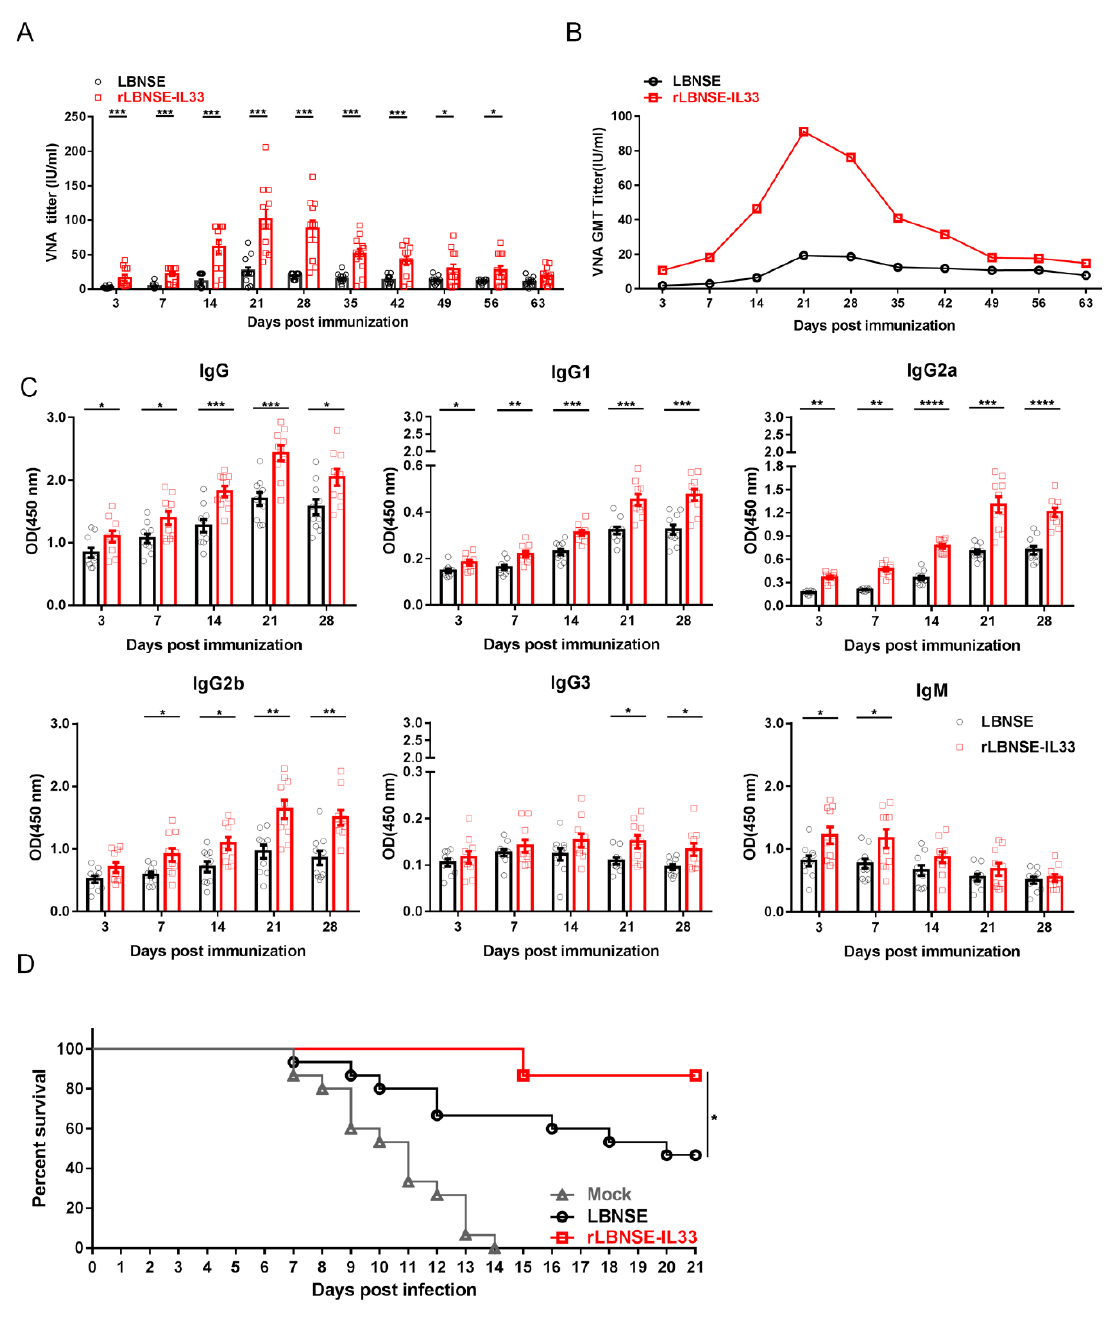
Figure 9. Overexpression of IL-33 in rRABV improved antibody responses and protection against rabies. Six-week-old female ICR mice were immunized with LBNSE (10 6 FFU), rLBNSE-IL33 (10 6 FFU), or DMEM (as mock) via i.m. route. Serum samples of vaccinated mice ( n = 10) were harvested and analysed by FAVN test at each indicated time points for nine weeks: ( A ) VNA level; ( B ) GMT; ( C ) absorbance at 450 nm of RABV-specific IgG, IgG1, IgG2a, IgG2b, IgG3, and IgG M antibodies based on ELISA. At 21 dpi, the immunized ICR mice ( n = 15) were challenged with 50 × LD 50 of CVS-24 via i.c. route, and monitored daily for three weeks; ( D ) survival rate after the challenge. The standard error (SE, n = 3) was illustrated by error bars, and the data were analyzed by unpaired two-tailed t-test. Significant differences between groups were indicated at three levels: *, p < 0.05; **, p < 0.01; ***, p < 0.001 and ****, p < 0.0001.